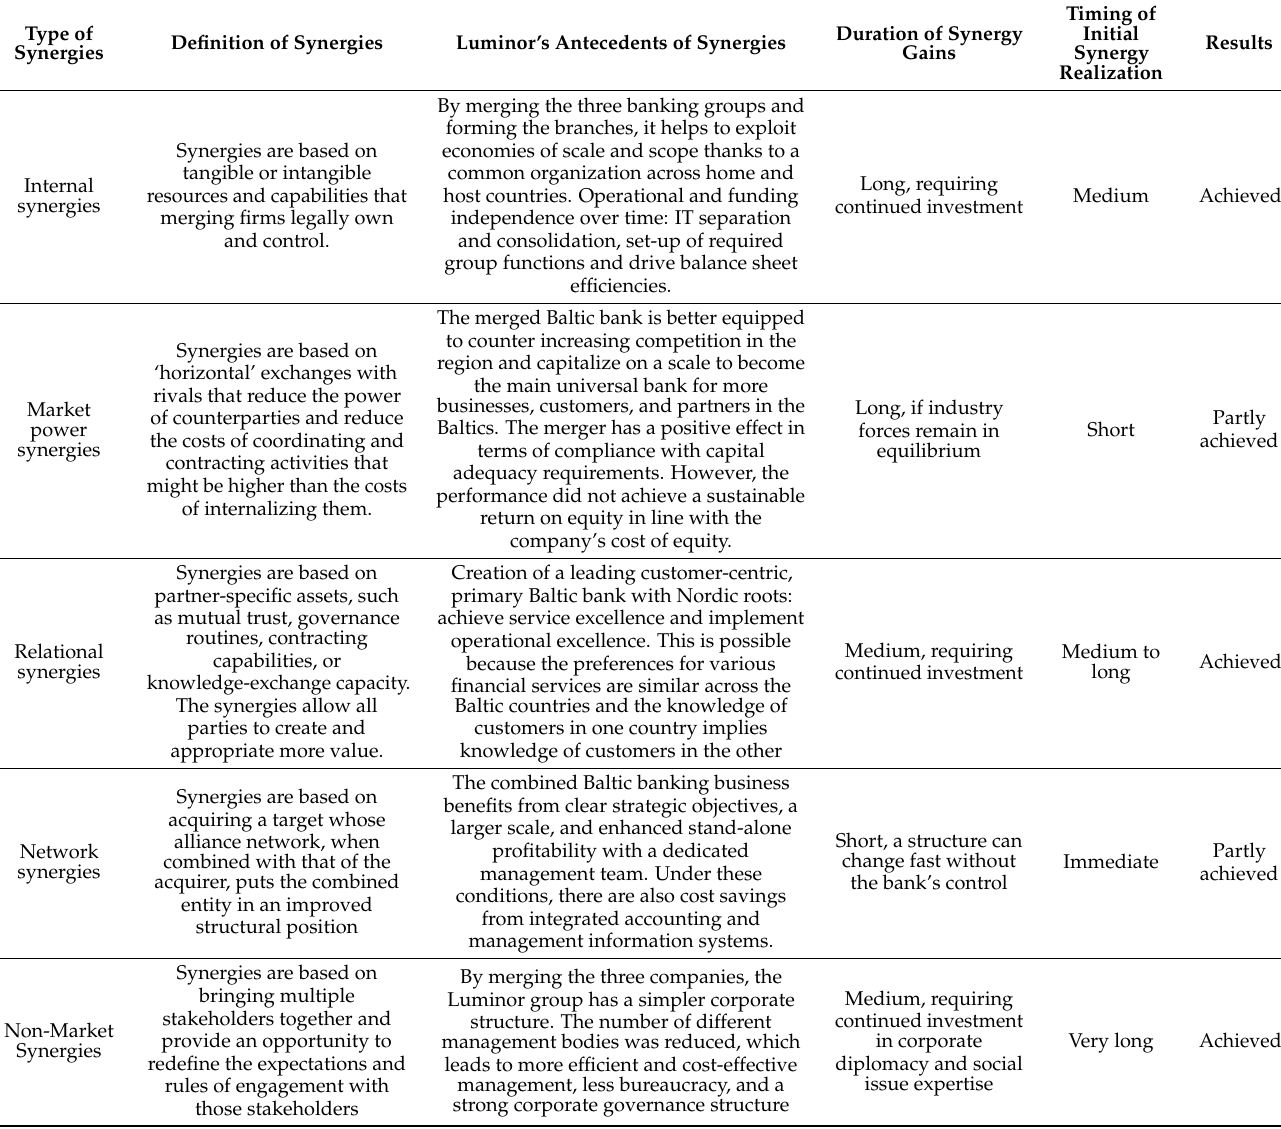
Table 2. Exploration of antecedents of Luminor’s synergies: Types, definitions, analyses, and results. Type of Synergies Definition of Synergies Luminor’s Antecedents of Synergies